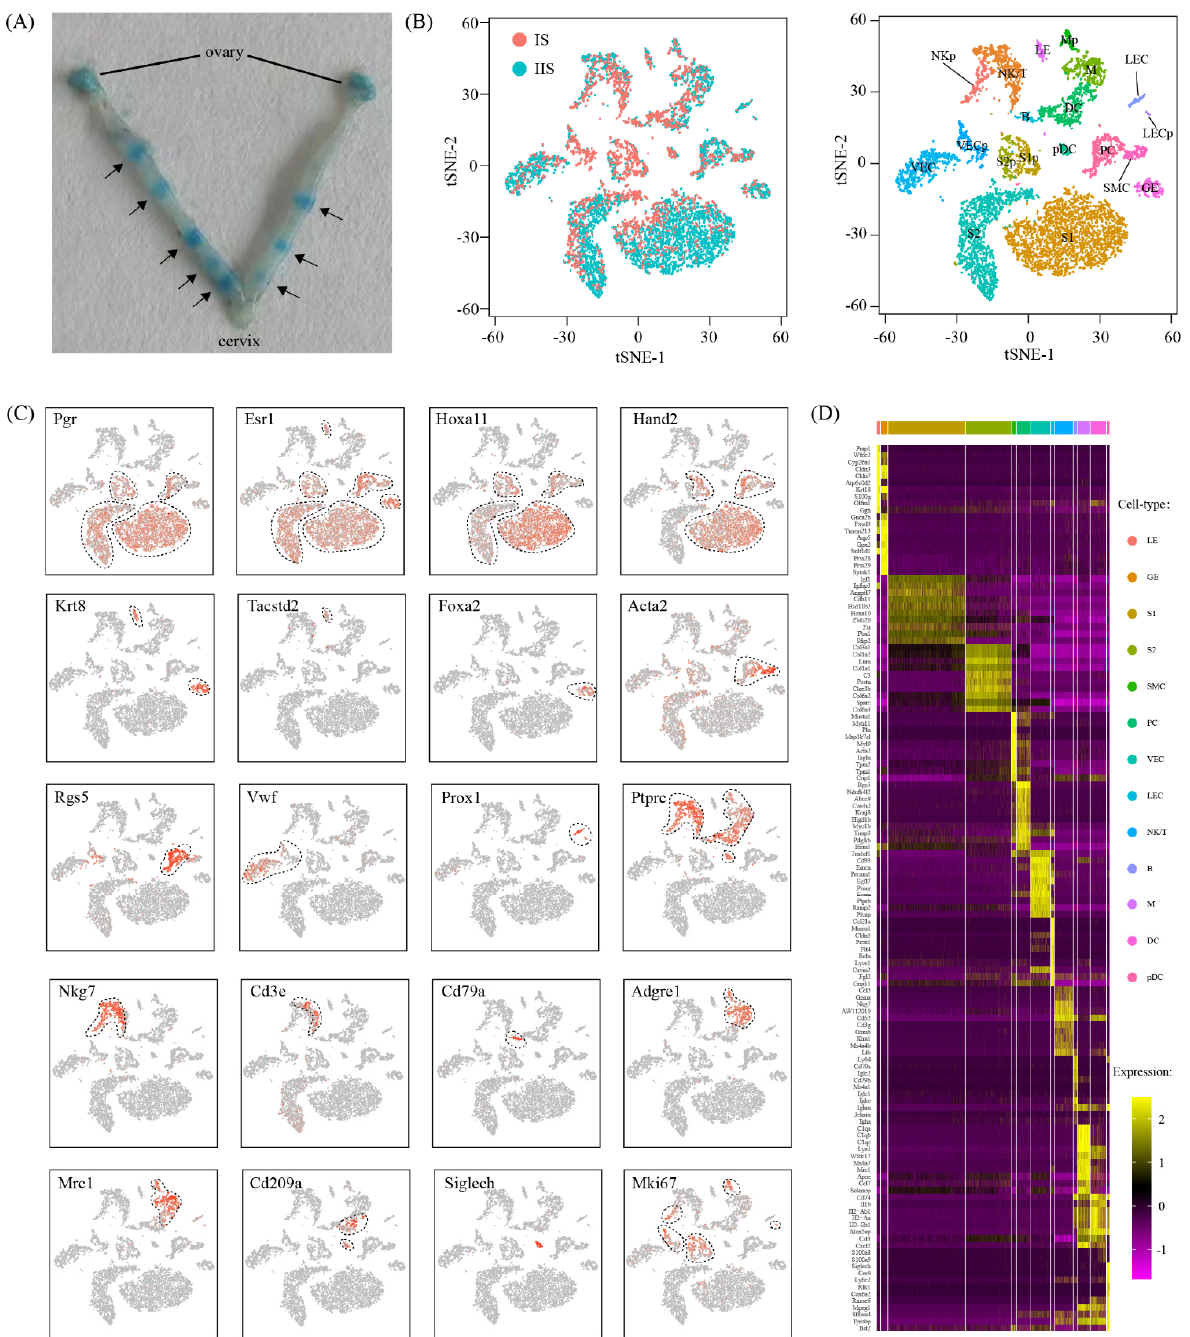
Figure 1. Single-cell transcriptome analysis of the implantation site in mouse uterus on gestational day 5: ( A ) A photograph of mouse uterus on gestational day 5. The position of embryo implantation sites was marked with an arrow. ( B ) The t-stochastic neighbor embedding (tSNE) representation of single-cell RNA-seq data obtained from implantation sites (IS) and inter-implantation sites (IIS). Single cells were grouped by cellular origin (left) and cell clusters (right). LE: luminal epithelial cells; GE: glandular epithelial cells; S1: superficial stromal cells; S2: deep stromal cells; S1p: proliferating superficial stromal cells; S2p: proliferating deep stromal cells; SMC: smooth muscle cells; PC: pericytes; VEC: vascular endothelial cells; VECp: proliferating vascular endothelial cells; LEC: lymphatic endothelial cells; VECp: proliferating lymphatic endothelial cells; M: macrophages; DC: dendritic cells; pDC: plasmacytoid dendritic cells; Mp: proliferating macrophages; NK/T: mixed natural killer cells and T cells; NKp: proliferating natural killer cells; B: B cells. ( C ) The expression pattern of canonical marker genes projected onto TSNE plots. Dashed lines denote the boundaries of the cell cluster of interest. ( D ) Heatmap of the top 10 gene expression signatures for each cell type.